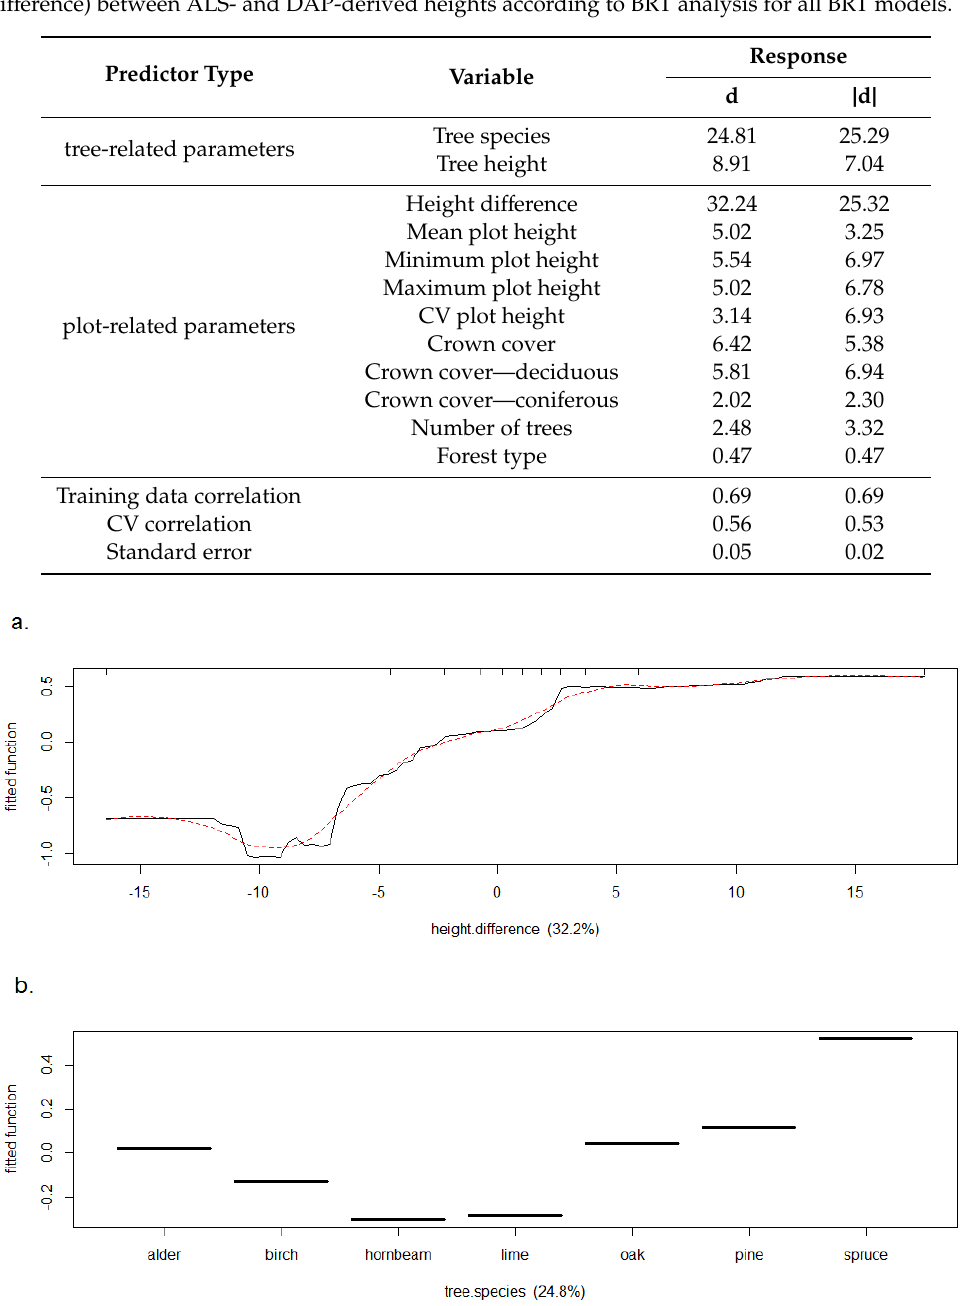
Figure 4. Partial dependency plots for the BRT model illustrating the relationship between the difference between ALS and DAP heights and height difference (a) and tree species (b). Percentages represent the relative contributions of the predictors to the BRT model. The fitted function (y-axis) reflects the effect of the predictors on the difference between the ALS and DAP heights after all other predictors are averaged. Each tick mark at the top of the graph represents a 10th percentile of the data.